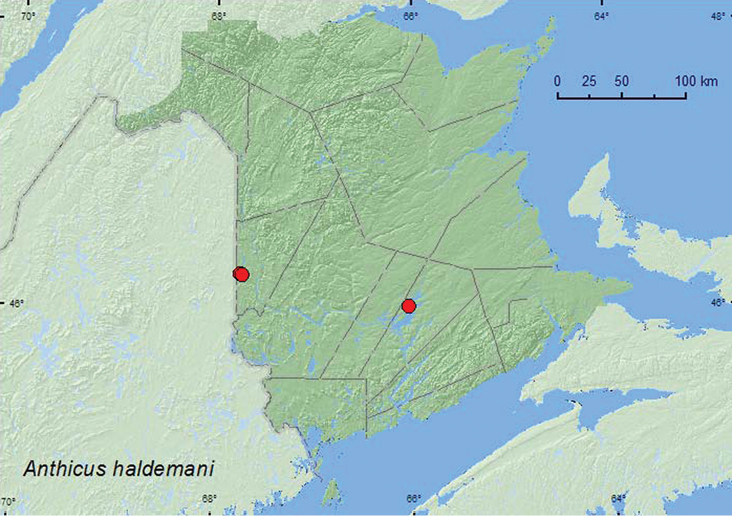
Collection localities in New Brunswick, Canada of Anthicus haldemani.